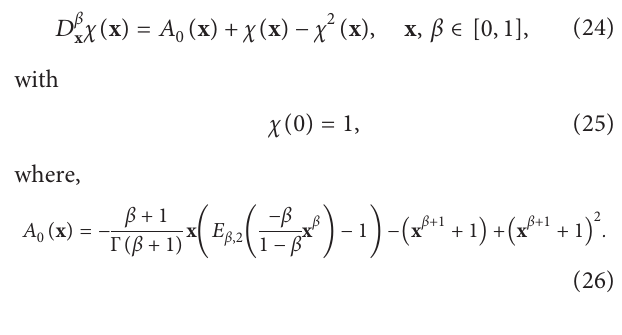
at x � 1 and β � 1 for Problem 3. A good agreement between them is